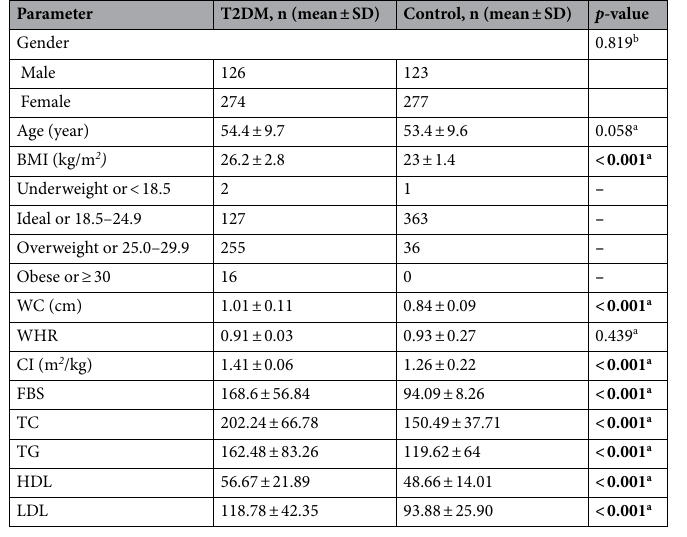
Table 1. Clinical and demographic data of patients with T2DM and healthy controls. T2DM Type 2 Diabetes Mellitus, n represents the numbers, BMI body mass index, WC waist circumference, WHR waist-to-hip ratio, CI conicity index, FBS fasting blood sugar, TC total cholesterol, TG triglyceride, HDL high-density lipoprotein, LDL low-density lipoprotein, a Mann–Whitney-Wilcoxon test; b Pearson Chi-Square test. Statistically significant parameters ( p -value < 0.05) are shown in Bold and